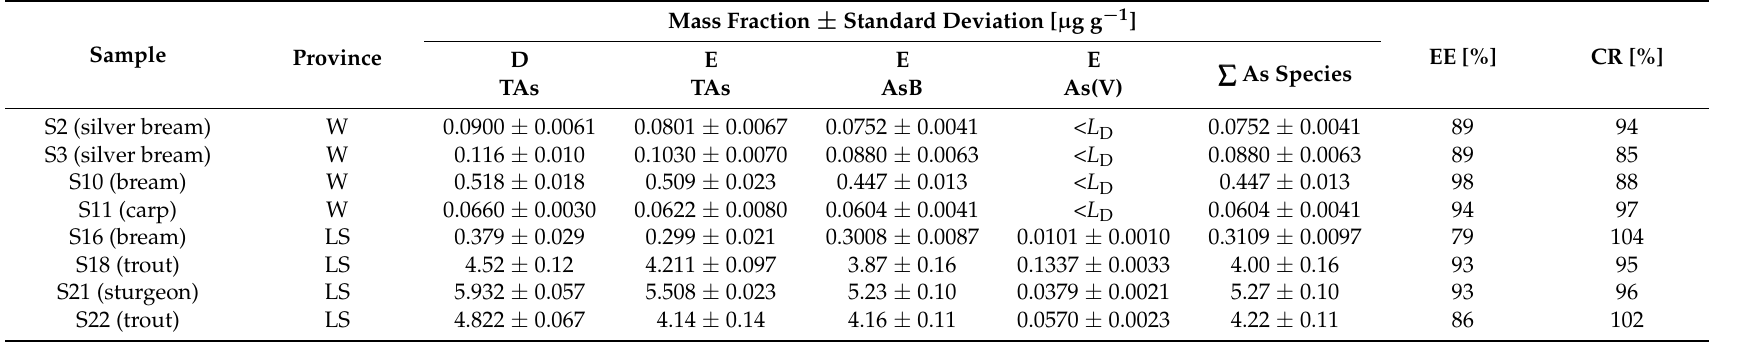
Table 5. Concentration of total arsenic and arsenic species in selected freshwater fish samples from Wielkopolska and Lower Silesia provinces ( n = 3).